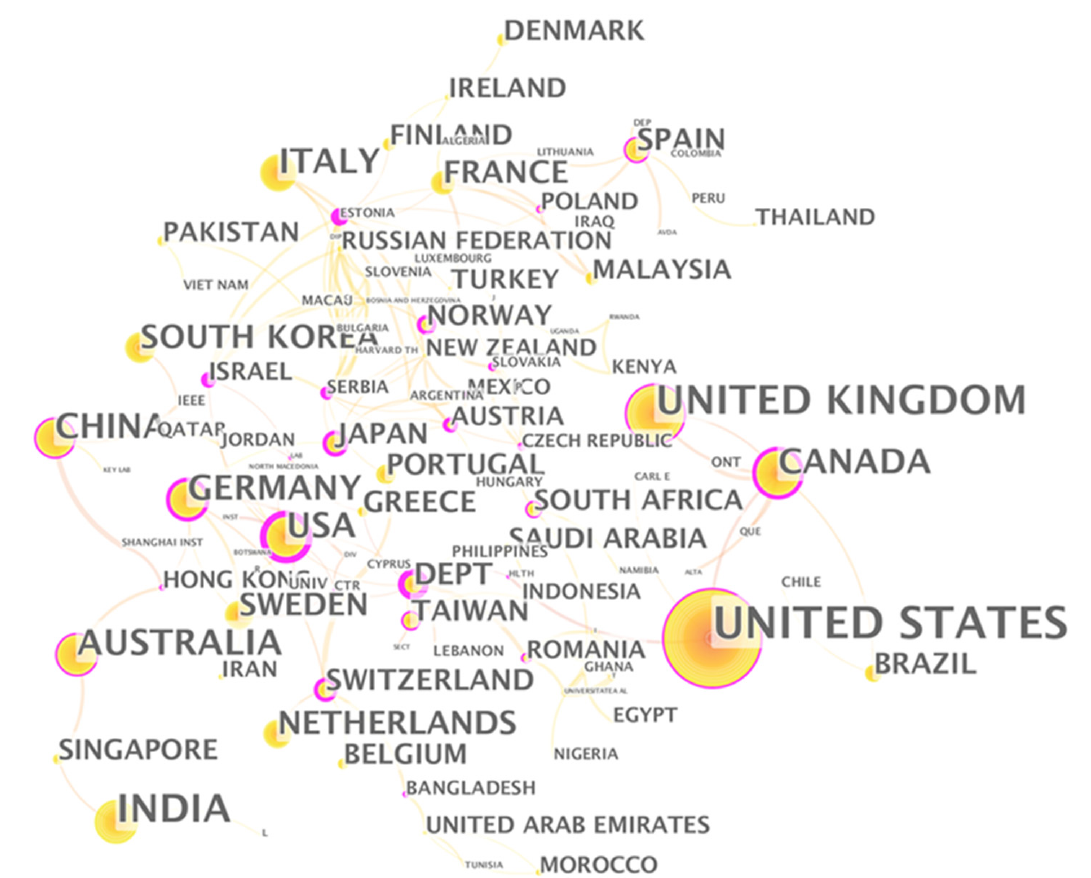
Figure 6 . The cooperation network of countries. Figure 6. The cooperation network of countries.